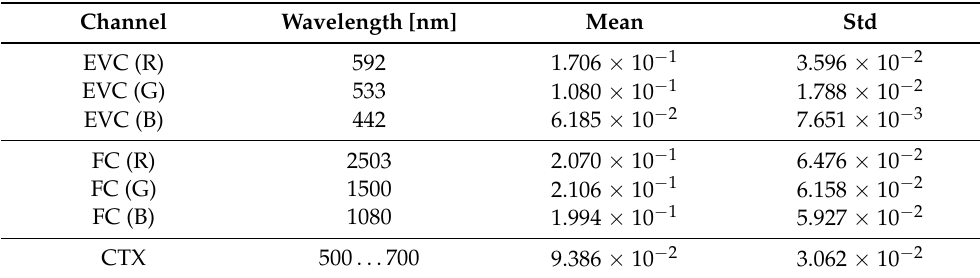
Table A1. Wavelength, mean and standard deviation of each CRISM and CTX channel examined in this